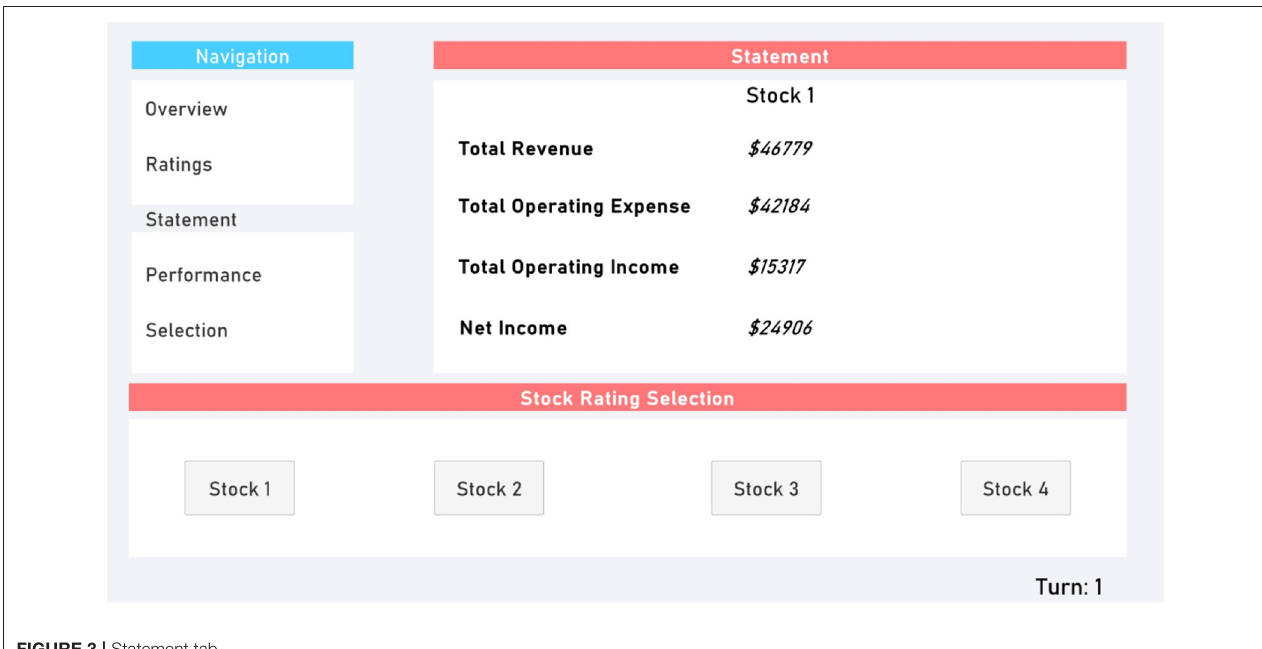
FIGURE 3 | Statement tab.